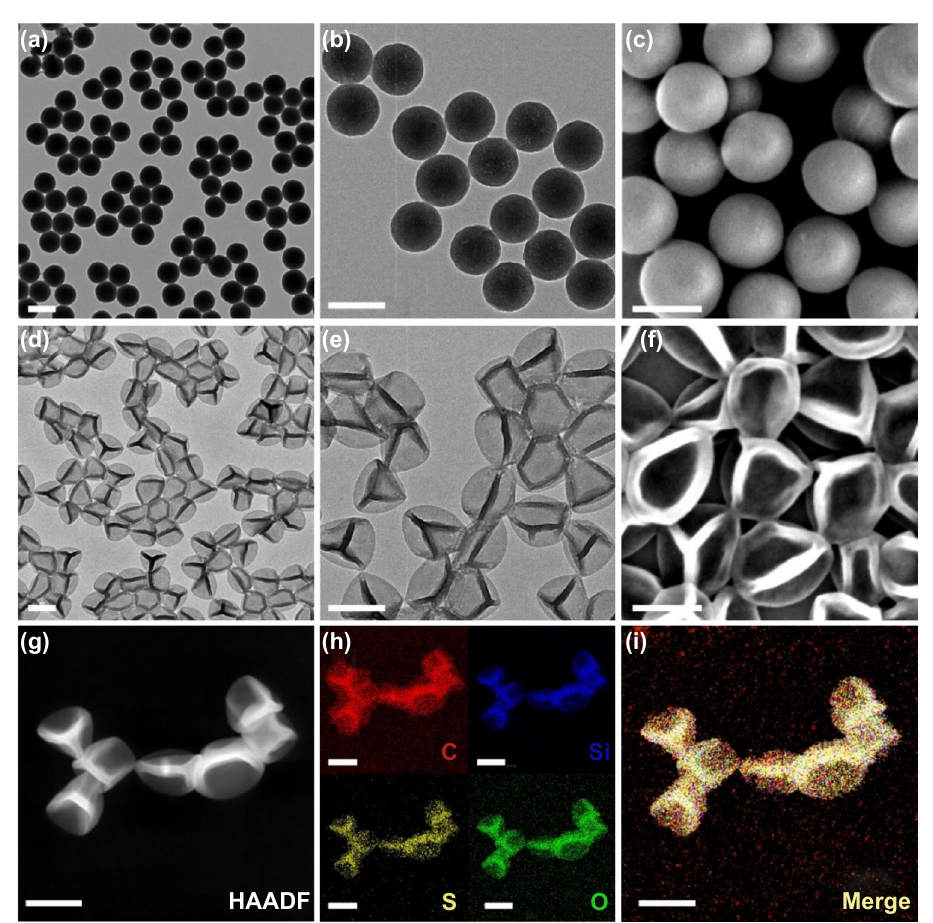
Fig. 1 a , b TEM and c SEM images of the MONs-HA-Cy5.5. d , e TEM and f SEM images of the SMONs-HA-Cy5.5. g STEM-HAADF image and h , i EDX elemental mapping images of the SMONs-HA-Cy5.5. Red, blue, yellow, and green indicate the elements C, Si, S, and O, respec- tively. Scale bars, 200 nm. (Color figure